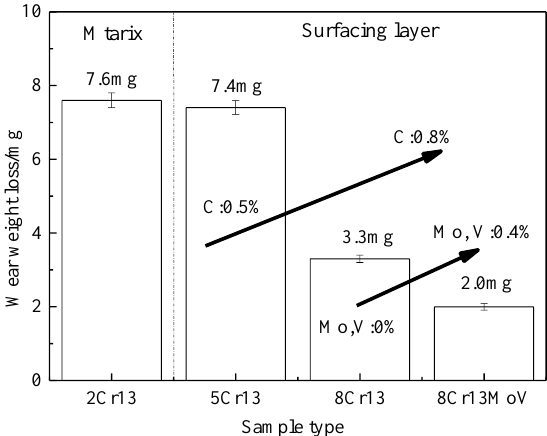
Figure 9. Wear weight loss of the matrix and the different surfacing layers.